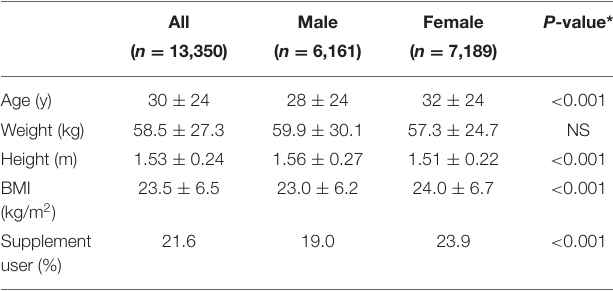
TABLE 1 | Participant characteristics from the UK National Diet and Nutrition Survey (NDNS) Years 1–9 (2008–2017).